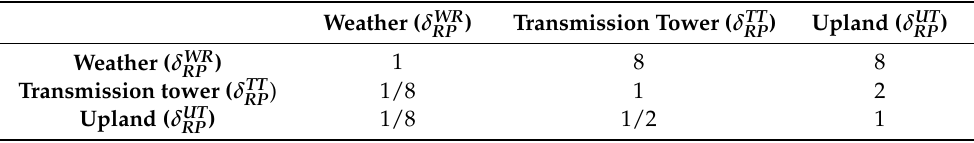
Table 16. Judgmental matrixes of threat source alternative hierarchy of recovery point.